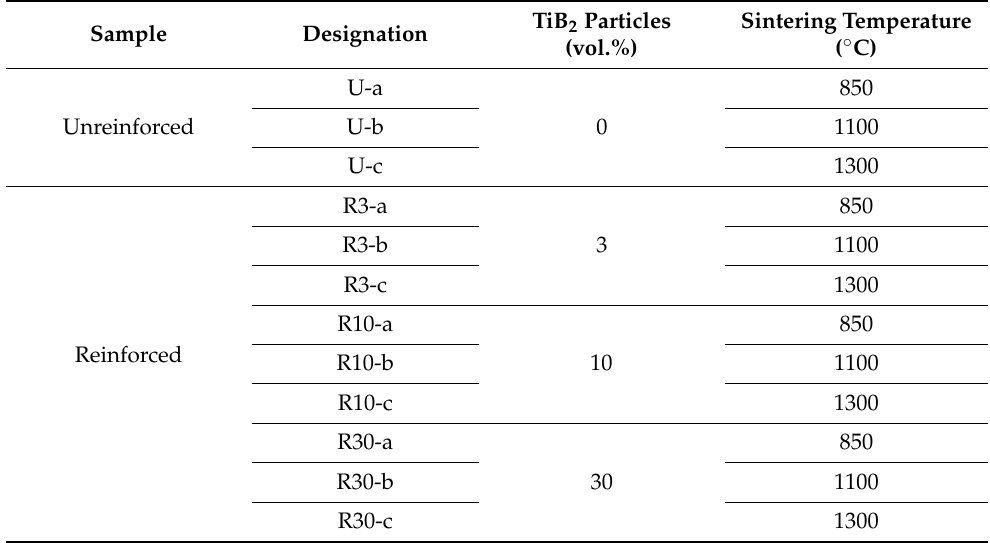
Table 1. Nominal content and designation samples, for the set of experimental sintering